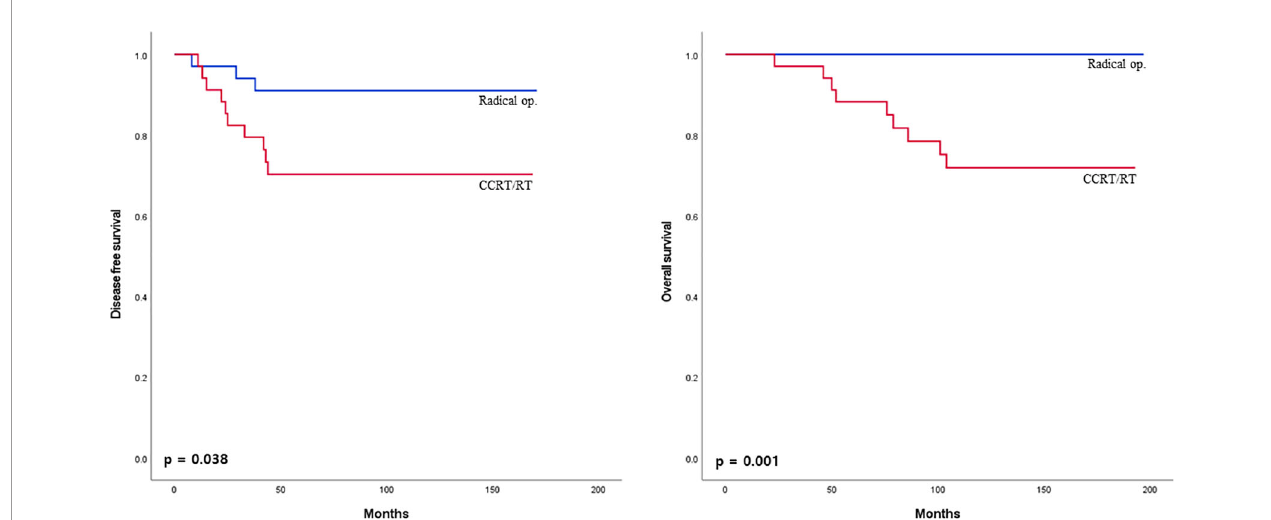
FIGURE 4 | Disease-free survival curves of patients with early rectal cancer between CCRT/RT and radical operation groups in patient with mid to low rectal cancer.